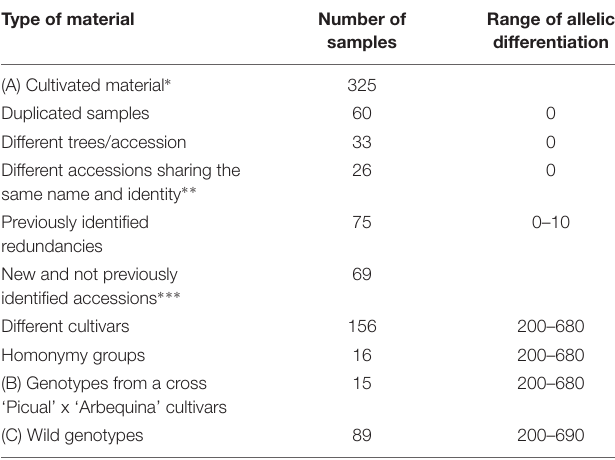
TABLE 1 | Number of samples analyzed for cultivars, wild plants and genotypes from breeding